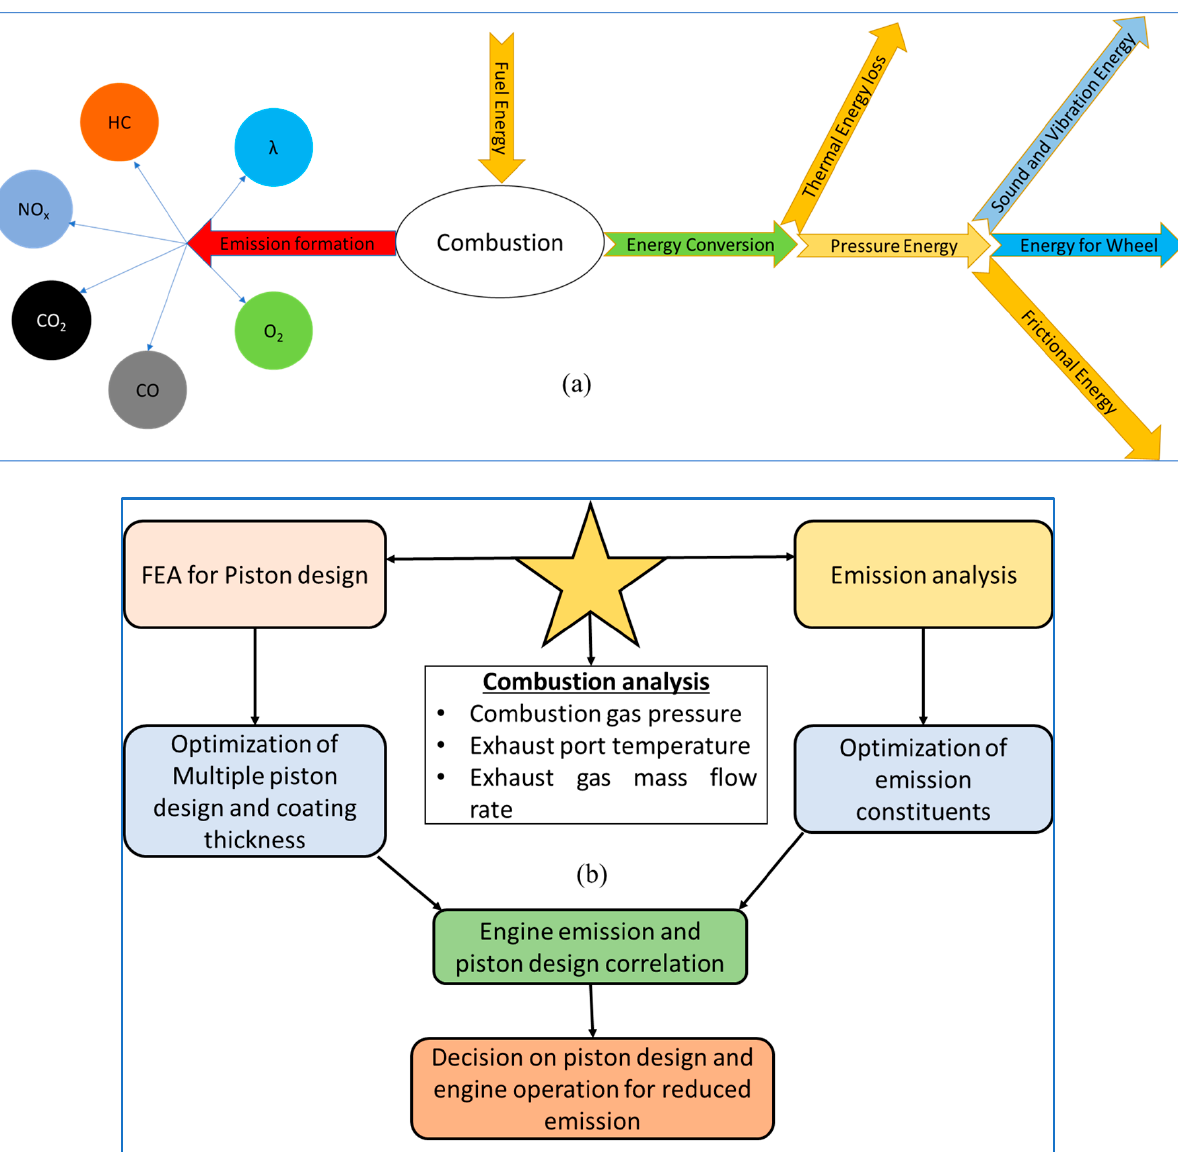
Figure 1. Framework for ( a )energy dynamics of engine system subjected to low-carbon alternatives; ( b )interfacing of fuel replacement and piston design to mitigate emission and improve energy effi- ciency.